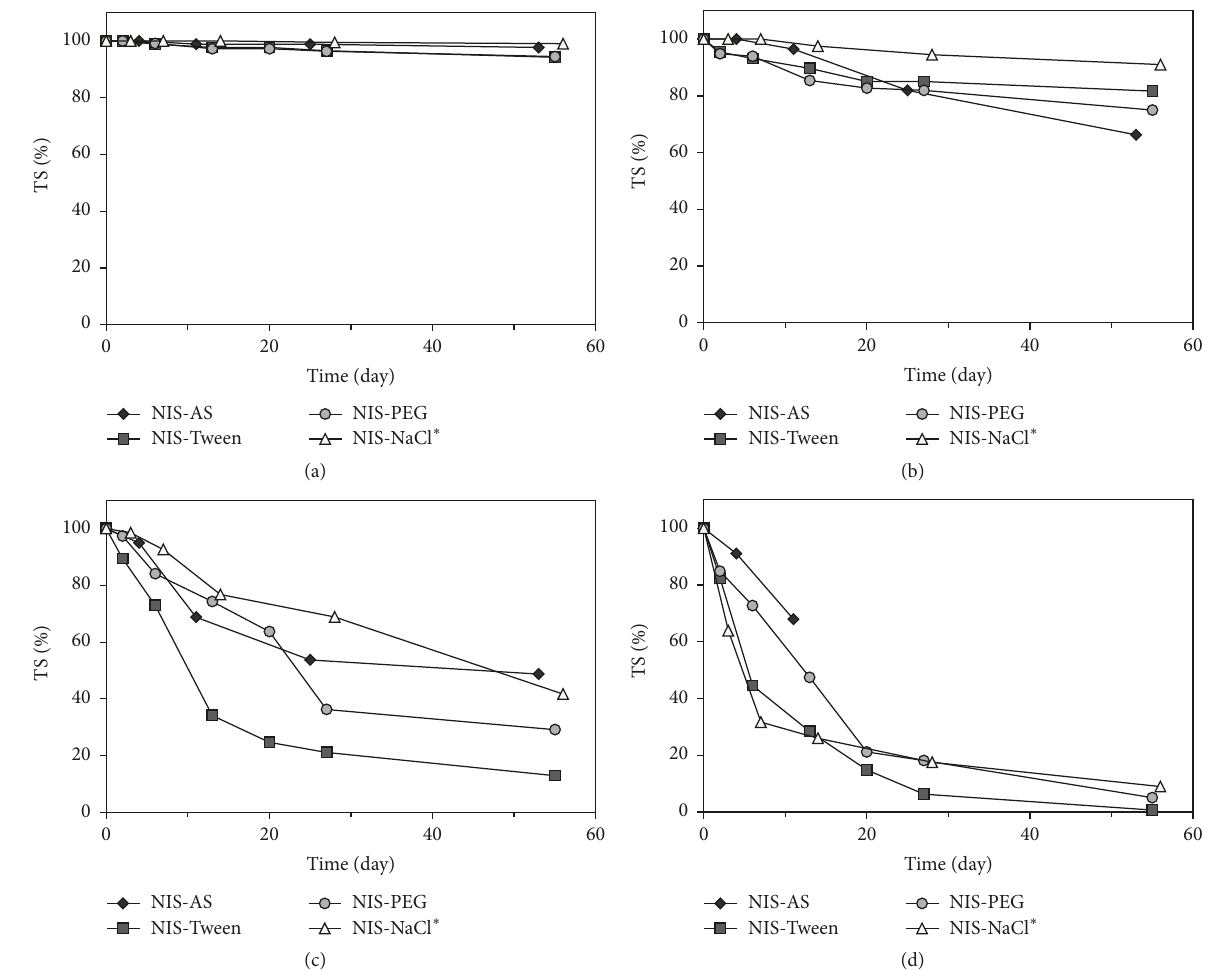
Figure 2: Thermal stability of nisin (TS) versus storage time at –18 ∘ C (a), 4 ∘ C (b), 25 ∘ C (c), and 55 ∘ C (d). Nisin was determined by HPLC. Data points are average values of three independent analyses. Standard errors were less than 10%. ∗ Commercial product.